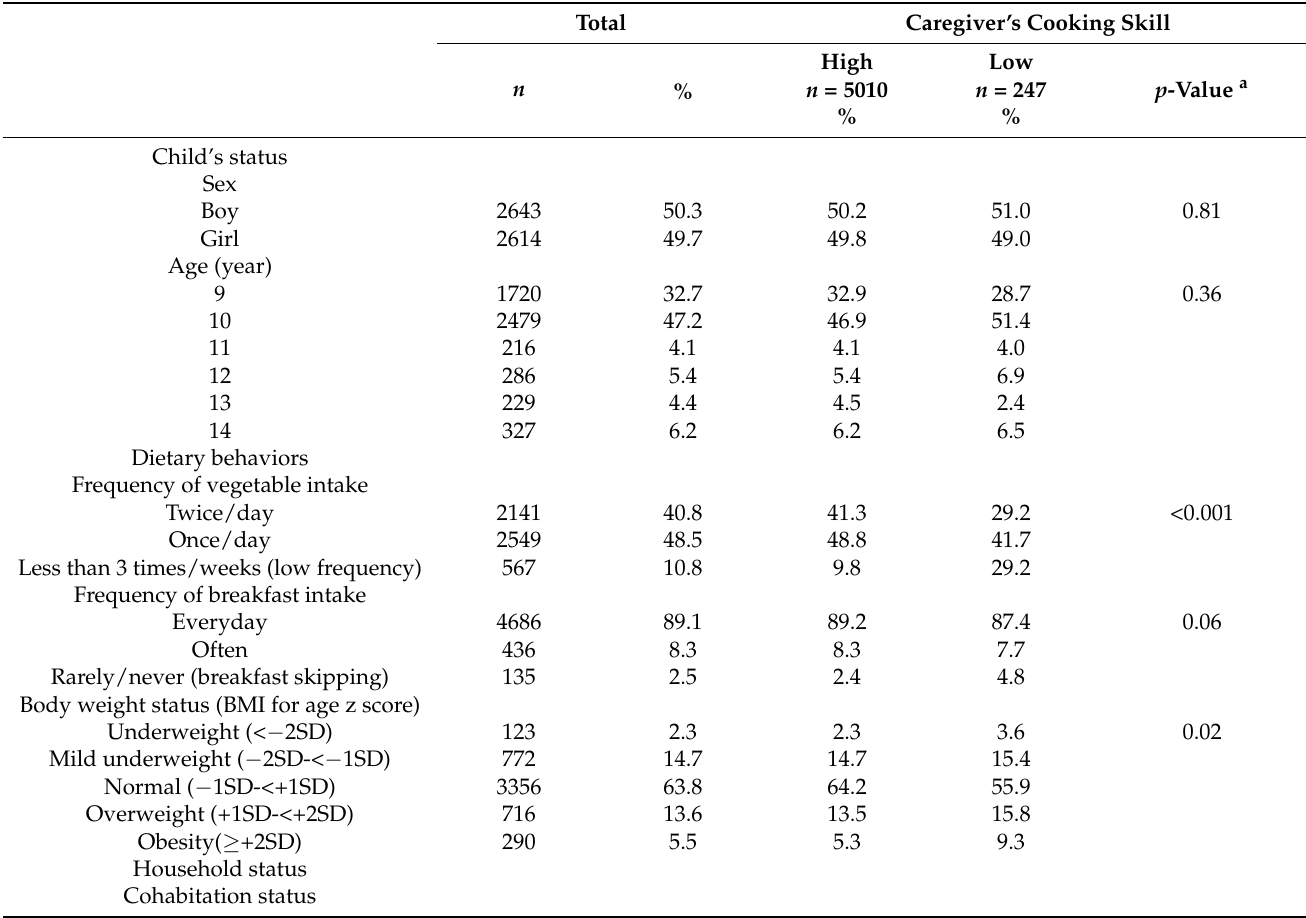
Table 1. Characteristics of Japanese school children and their caregivers ( n =